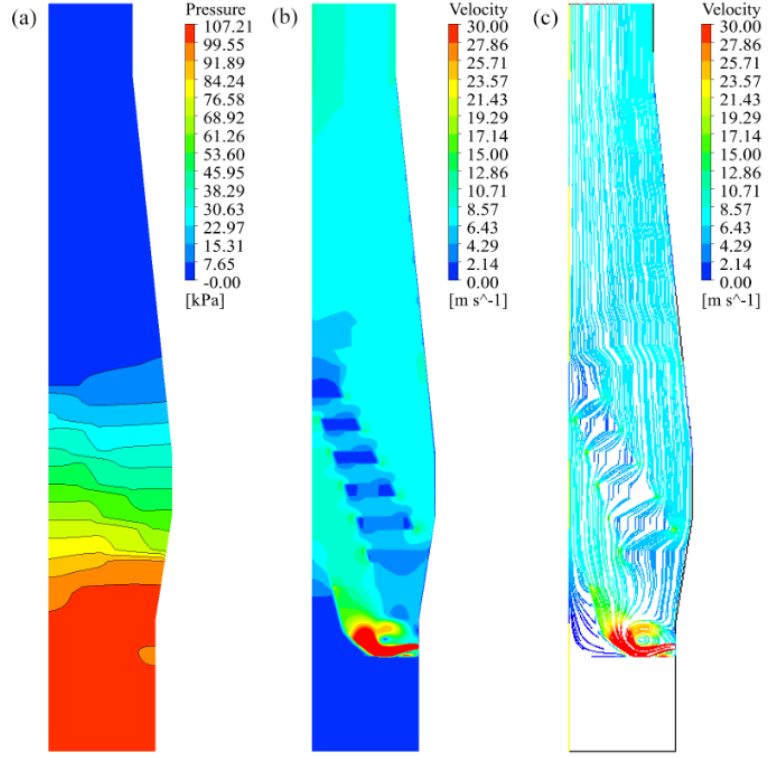
Figure 4. Contour and path line of traditional BF (without central coke, R = 50%, γ = 60 ◦ , n = 6): ( a ) pressure contour, ( b ) velocity contour, and ( c ) path line.